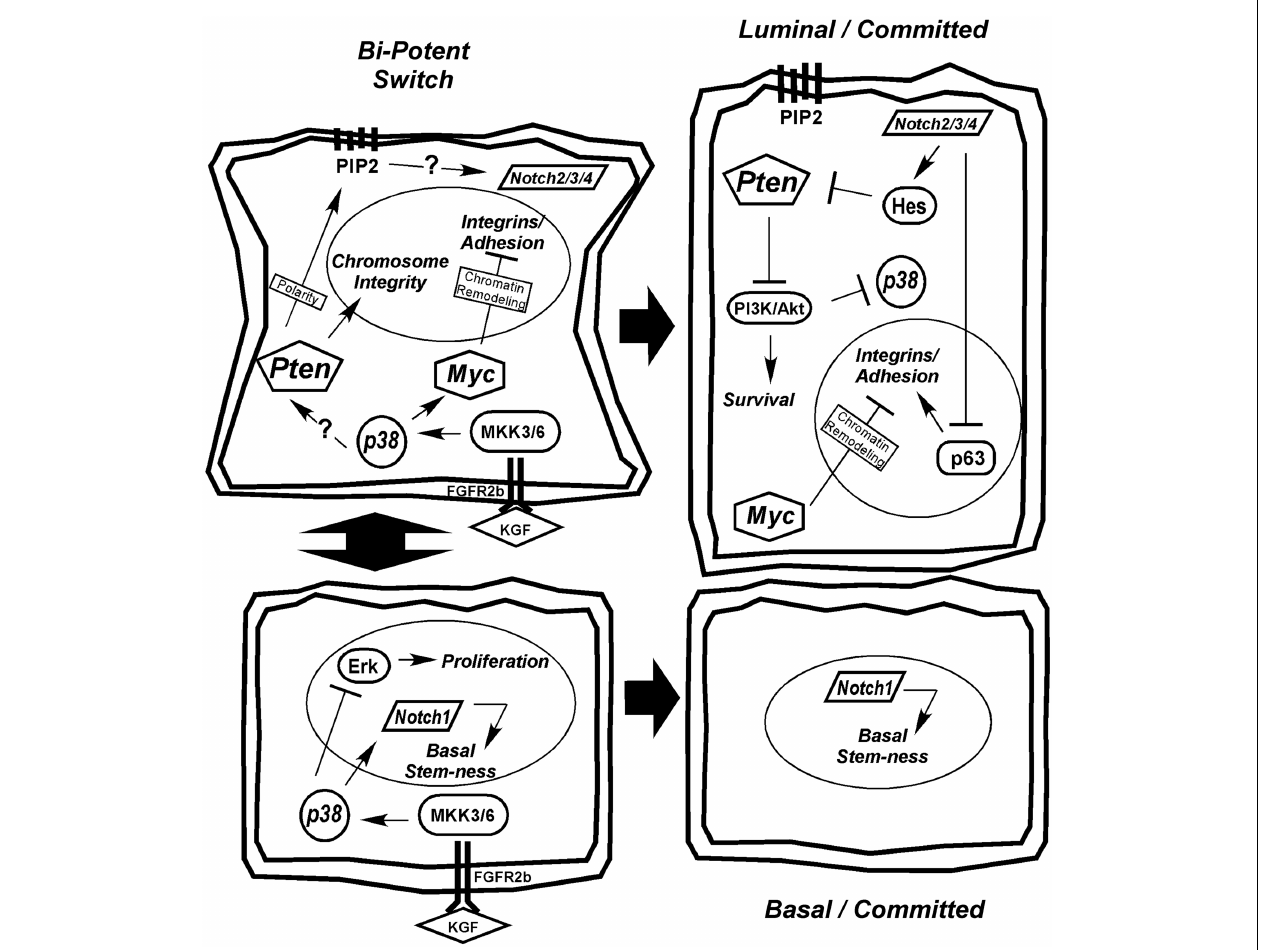
may be mediated by elevated Pten, via an unknown mechanism, to generate a PIP2 gradient at the apical membrane to establish cell polarity. Notch2/3/4 signaling in combination with Myc suppresses integrin expression allowing cells to detach. Luminal cells become dependent on PI3K signaling for survival as they lose matrix adhesion and integrin expression. Ultimately, Pten is partially suppressed to allow PI3K/Akt-dependent survival of the terminally differentiated luminal cell and the p38 differentiation program is